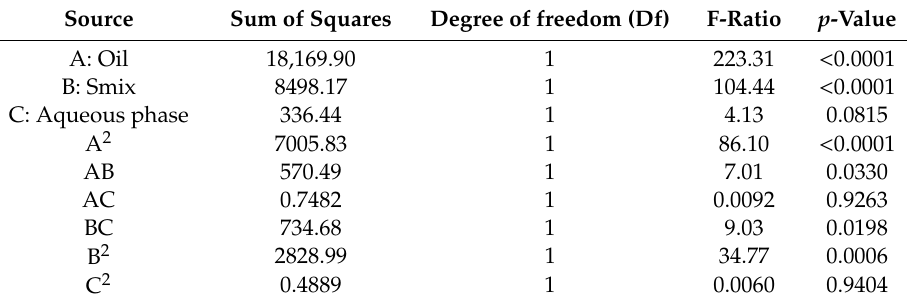
Table 2. Analysis of variance data for droplet